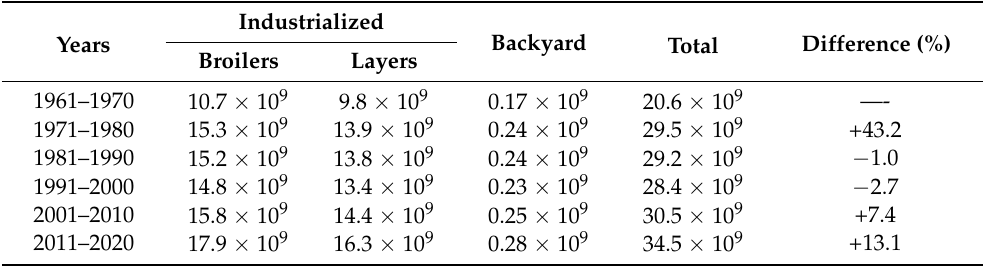
Table 1. GHG emissions of the chicken population (layers, broilers, and backyards) reared at the national level (kg CO 2 -eq/year) and the differences observed between each sequential examined decade. Industrialized Backyard Total Difference (%) Years Broilers